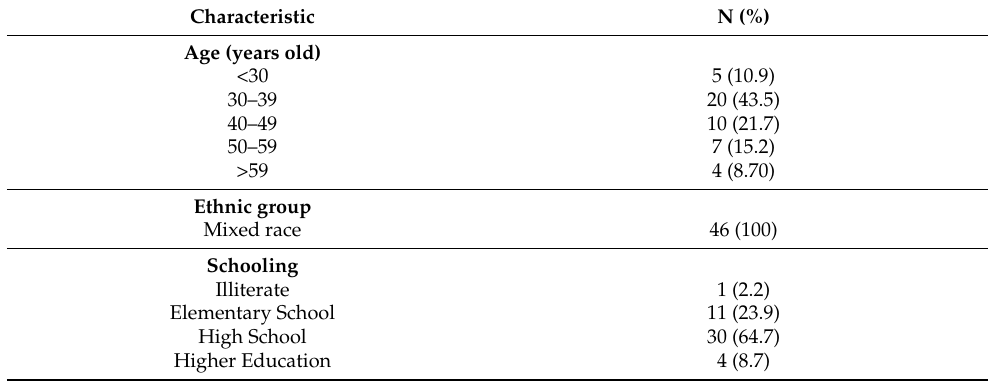
Table 3. Socio-demographic characteristics.